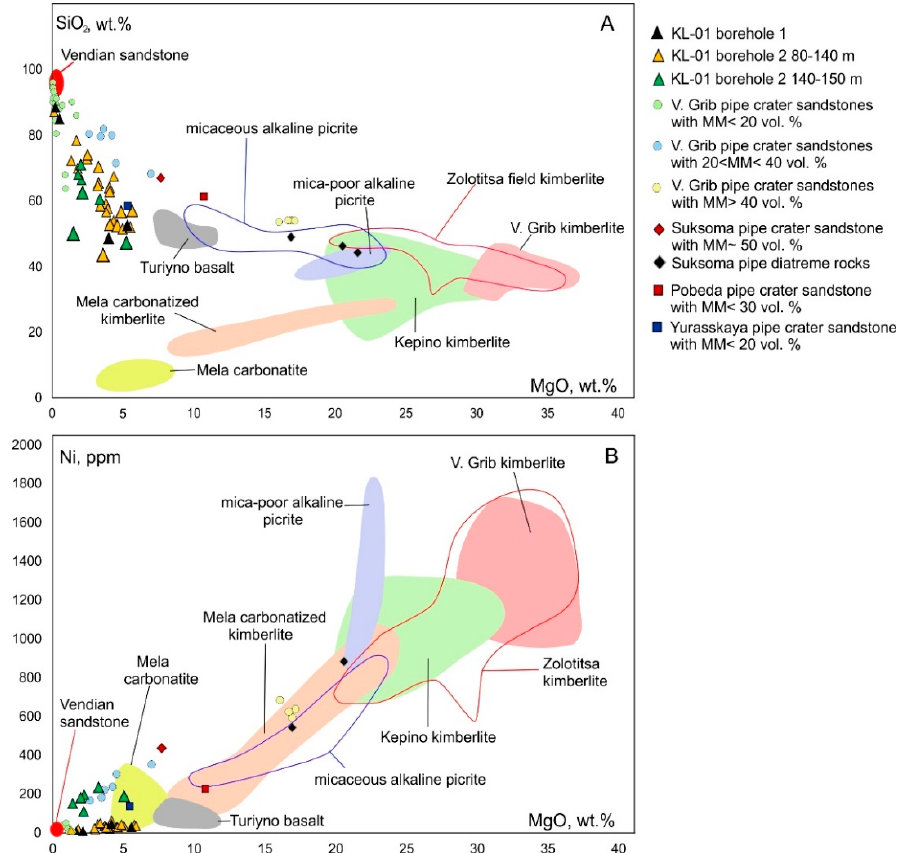
Figure 7. SiO 2 -MgO ( A) and Ni/MgO ( B ) relations diagrams for the KL-01 pipe sandstones, crater sediments of the V. Grib, Pobeda and Yurasskaya kimberlite pipes and Suksoma olivine melilitite/picrite pipe. The error bars are smaller than symbol size. Data for the ADP magmatic rocks from [9,10,13,14,17,19,20,27].